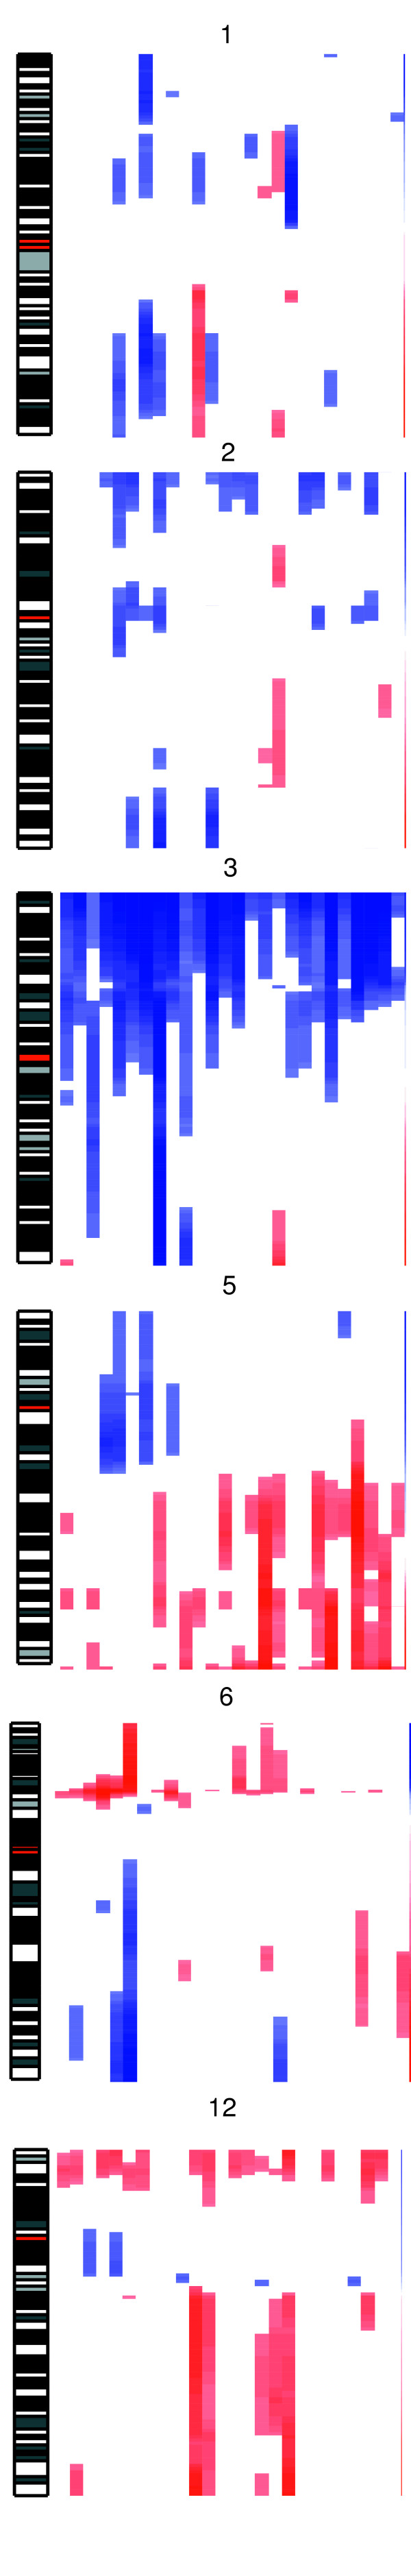
Identification of REBs from individual ccRCC samples. 27 ccRCC samples were analyzed for REBs and plotted as described in Figure 2a with the exception that chromosomes 1, 2, 3, 5, 6, and 12 are shown. Chromosomes 1 and 2 are shown as representative regions that do not frequent REBs. Data for all autosomal chromosomes was also generated [see Additional file 3].